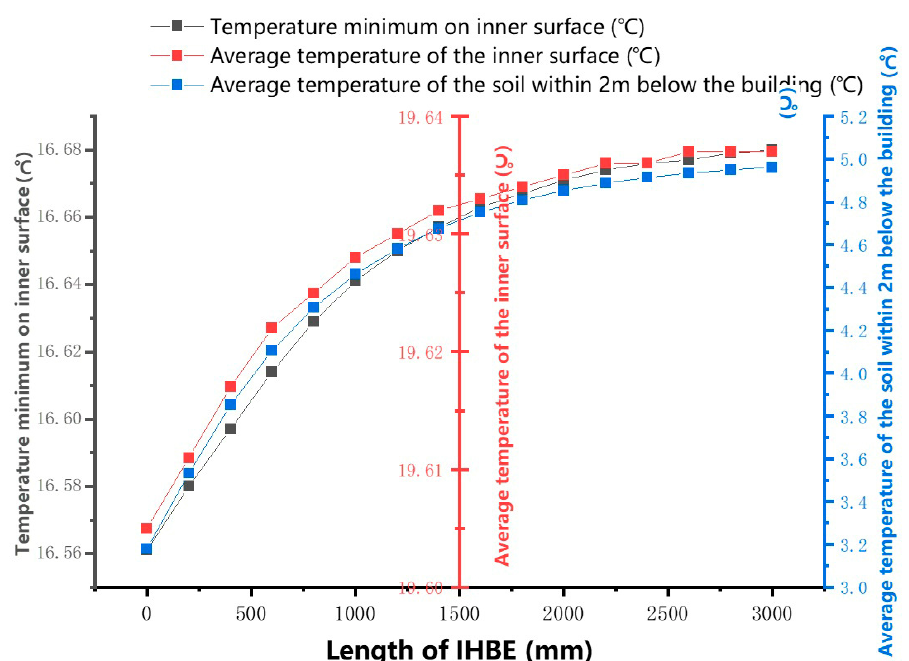
Figure 9. Length of IHEB versus each temperature.